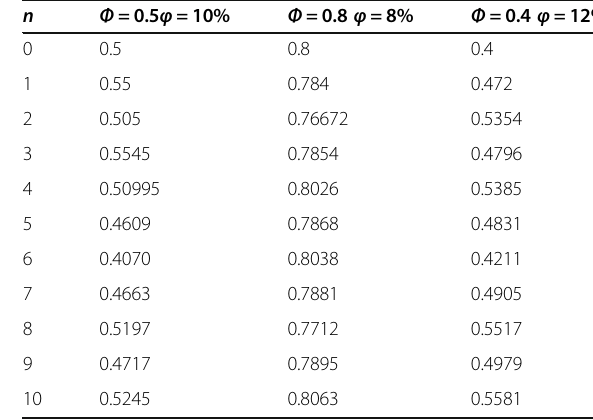
Table 6 Change of node 3 trust value in Case